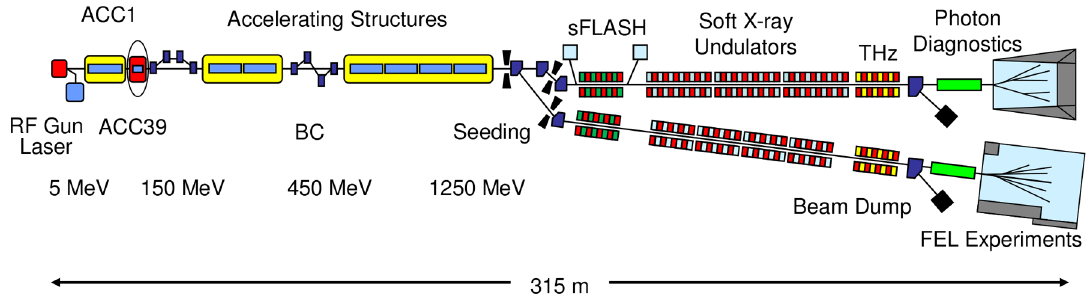
FIG. 1. Schematic view (not to scale) of the FLASH facility at DESY in Hamburg. The third harmonic module ACC39 (marked in red) is mounted between the first accelerating module (ACC1) and the first bunch compressor (BC). The picture was adapted from DESY